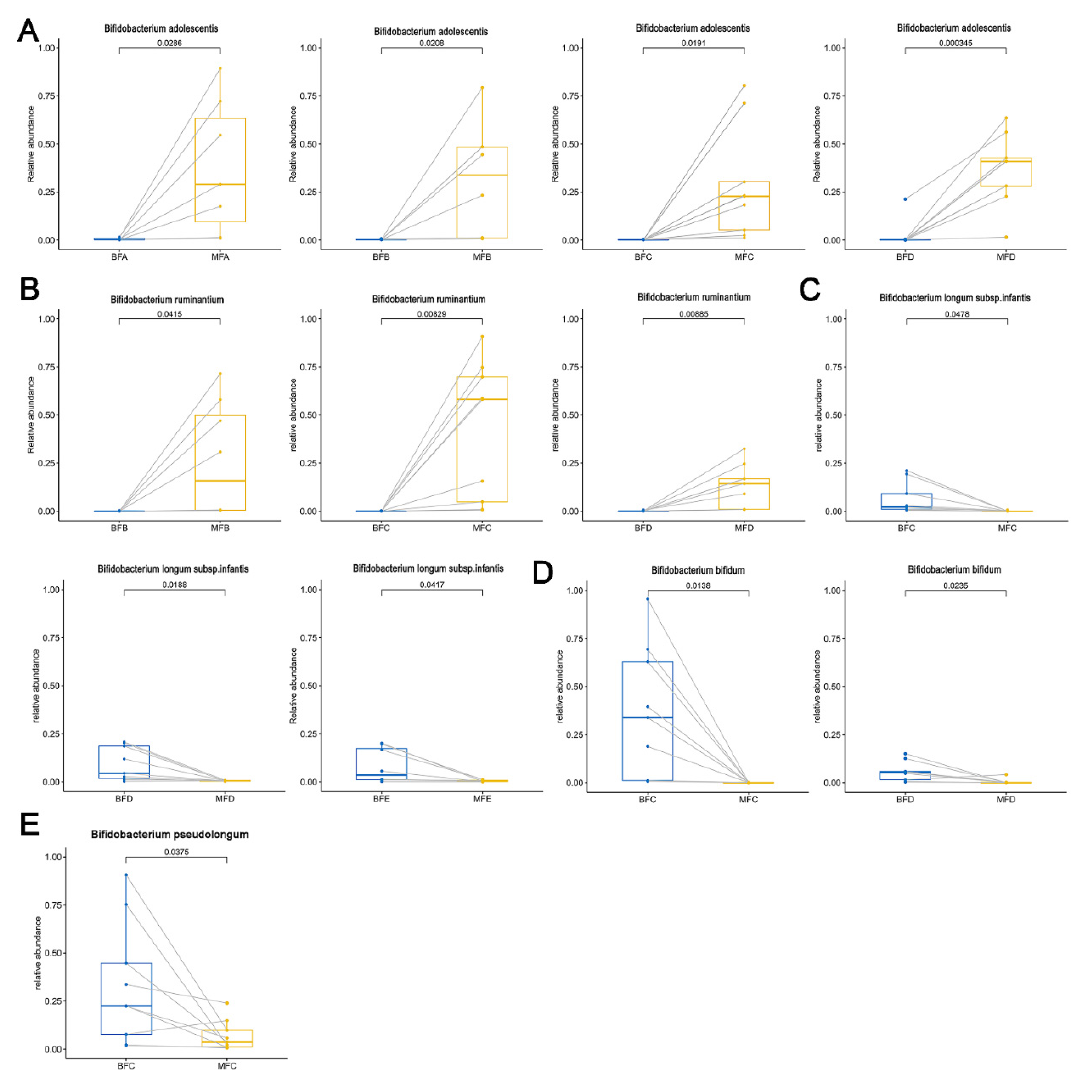
Figure 8. Differences of Bifidobacterium at species level in maternal and infant feces. ( A – E ) stand for significant difference of Bifidobacterium adolescentis , Bifidobacterium ruminantium , Bifidobacterium longum subsp. infantis , Bifidobacterium bifidum , and Bifidobacterium pseudolongum in maternal and infant feces, respectively. The two points connected by a line are the same mother-infant pair. MFA: maternal feces (corresponding to infant younger than one month of age), MFB: maternal feces (corresponding to infant between 1 and three months of age), MFC: maternal feces (corresponding to infant between three and six months of age), MFD: maternal feces (corresponding to infant between six and 12 months of age), MFE: maternal feces (corresponding to infant older than 12 months of age), BFA: infant feces younger than one month of age, BFB: infant feces between 1 and three months of age, BFC: infant feces between three and six months of age, BFD: infant feces between six and 12 months of age, BFE: infant feces older than 12 months of age.